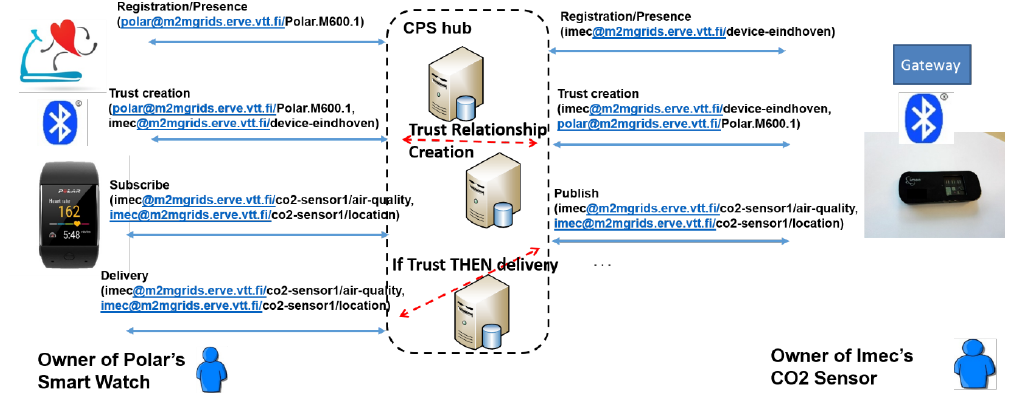
Figure 18. Interaction process of smart watch via the CPS hub with remotely located air quality sensor.